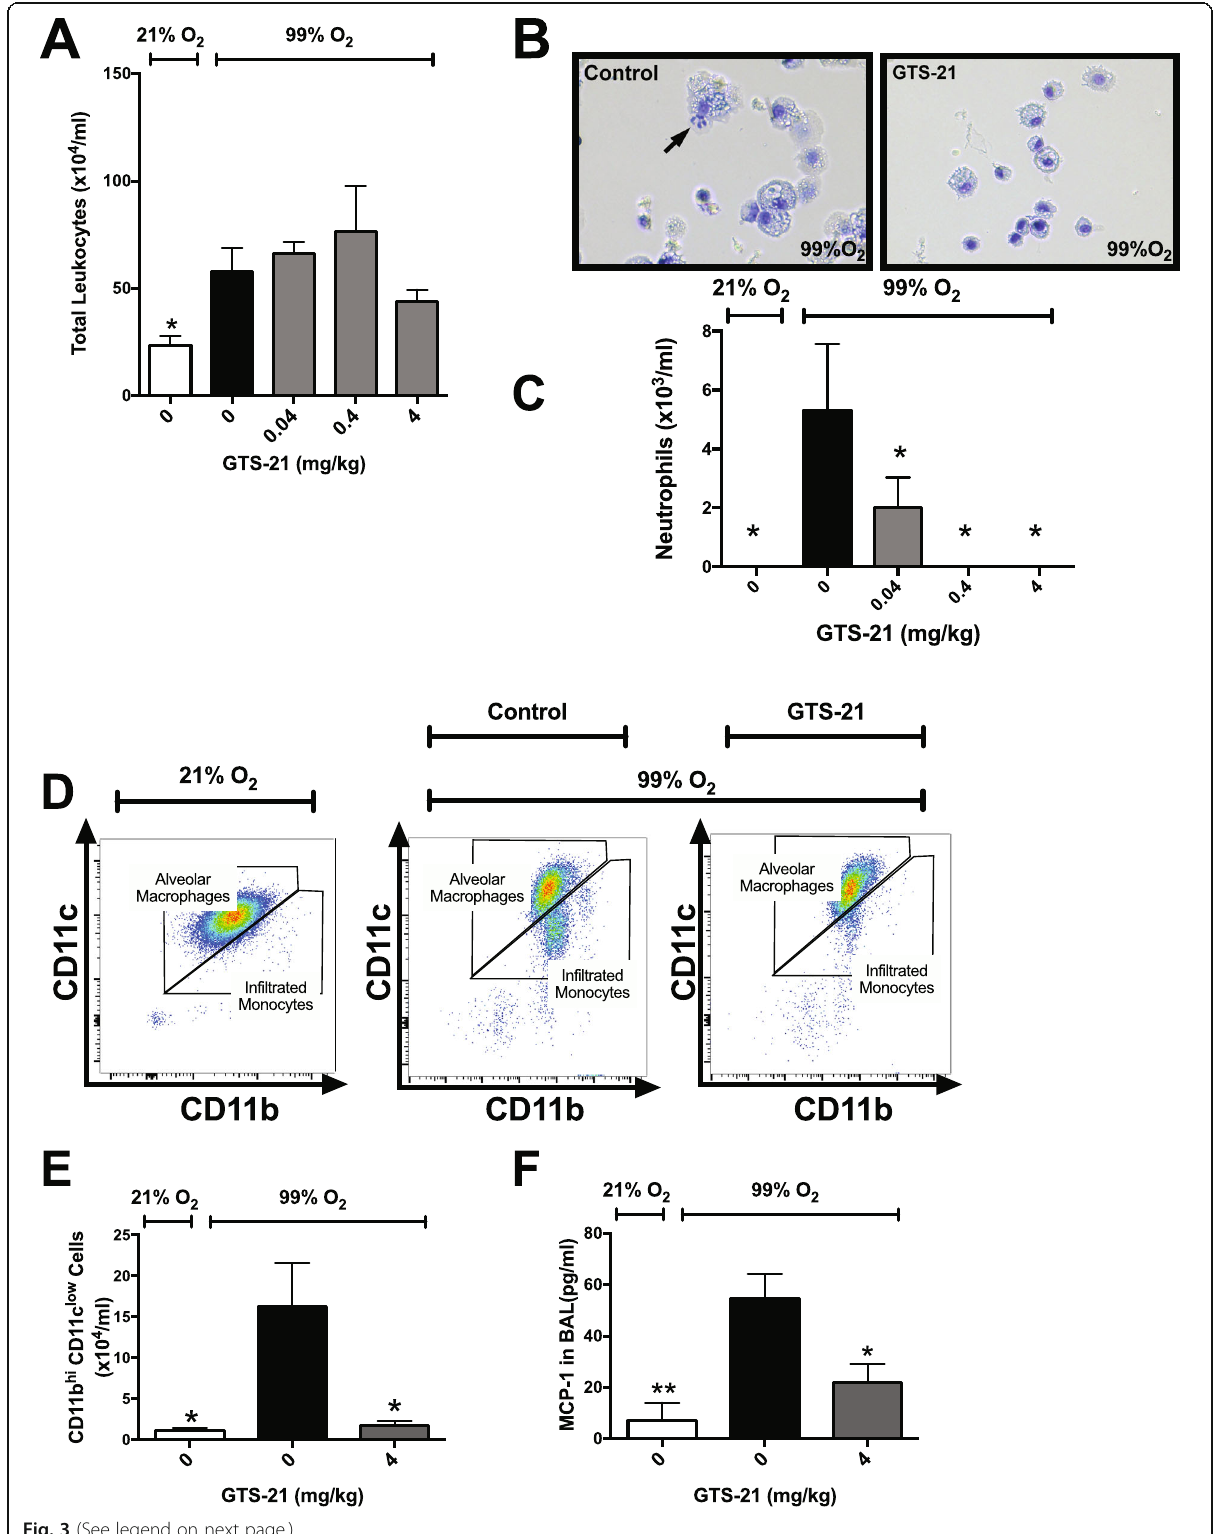
Fig. 3 (See legend on next